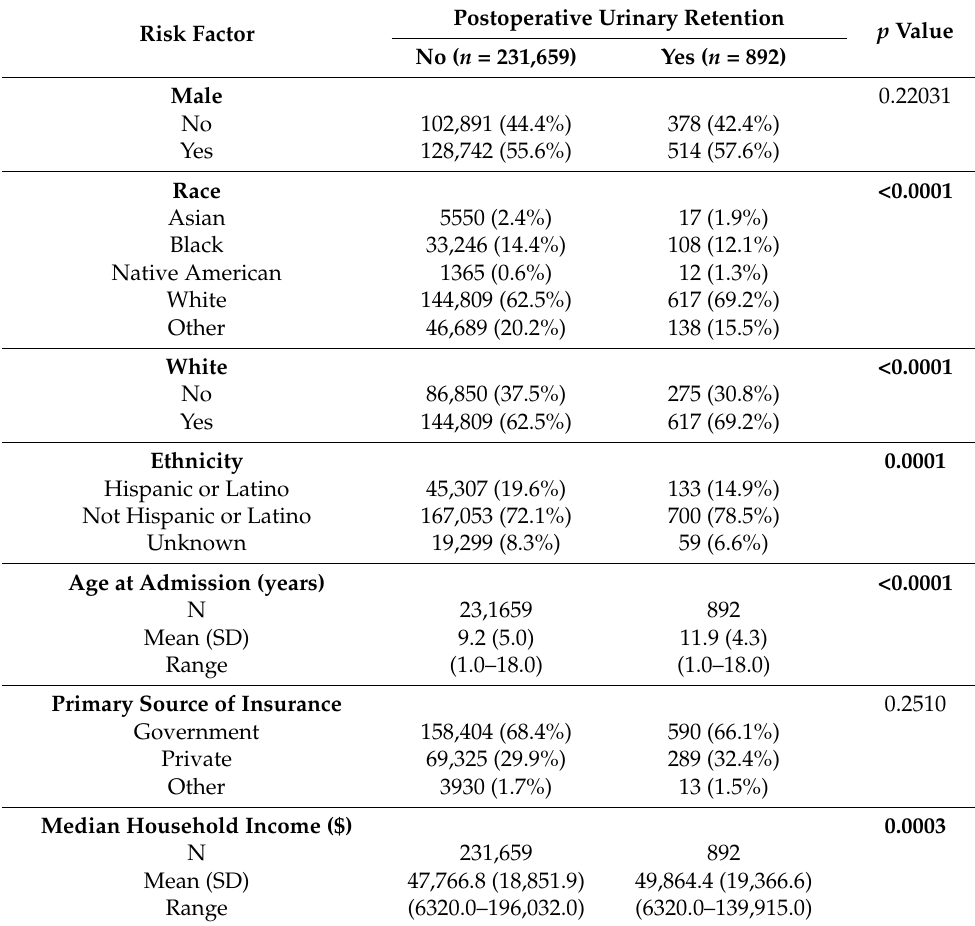
Table 1. Risk factors by postoperative urinary